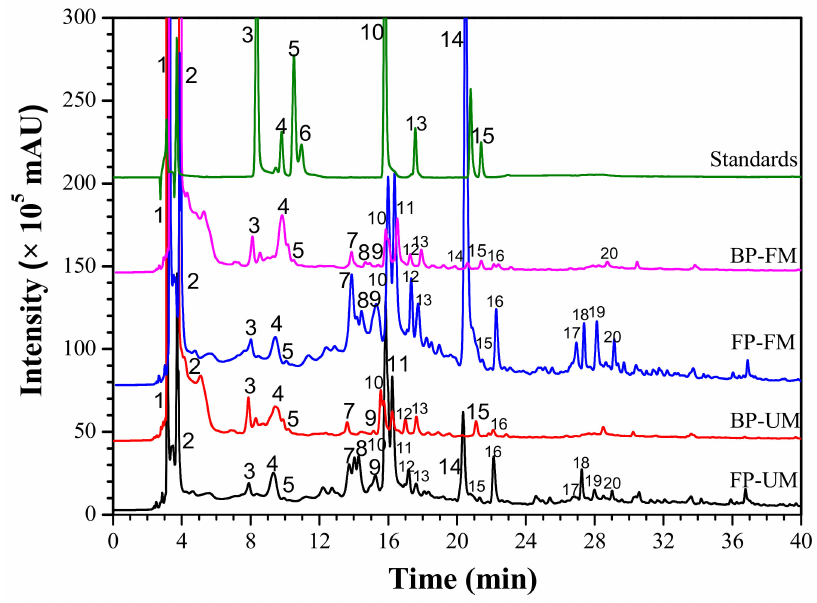
Figure 1. HPLC chromatogram (280 nm) of different extracts fractions of RTF in two ripening stages and the standards. FP-FM, free phenolic fraction of fully mature R. tomentosa fruits; FP-UM, free phenolic fraction of un-fully mature R. tomentosa fruits; BP-FM, bound phenolic fraction of fully mature R. tomentosa fruits; BP-UM, bound phenolic fraction of un-fully mature R. tomentosa fruits. Peaks: 1, gallic acid; 2, protocatechuic acid; 3, vanillic acid; 4, p -hydroxycinnamic acid; 5, ellagic acid; 10, luteolin-7- O -glucoside; 13, astragalin; 14, syringetin-3- O -glucoside; 15,